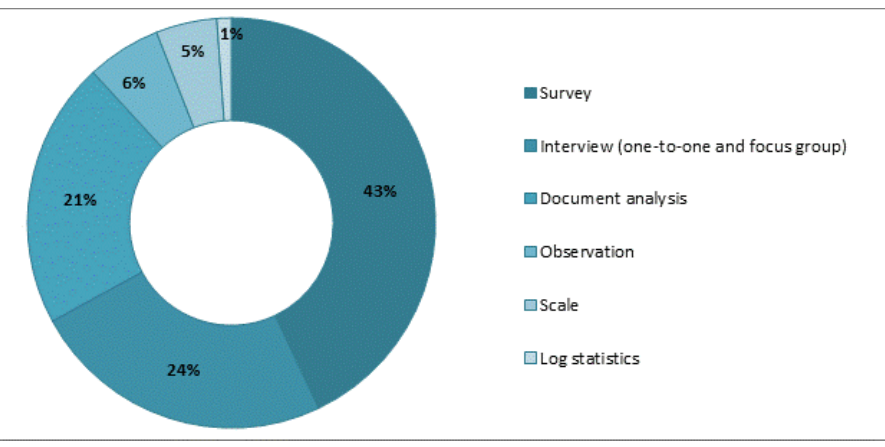
Figure 5 . Data collection